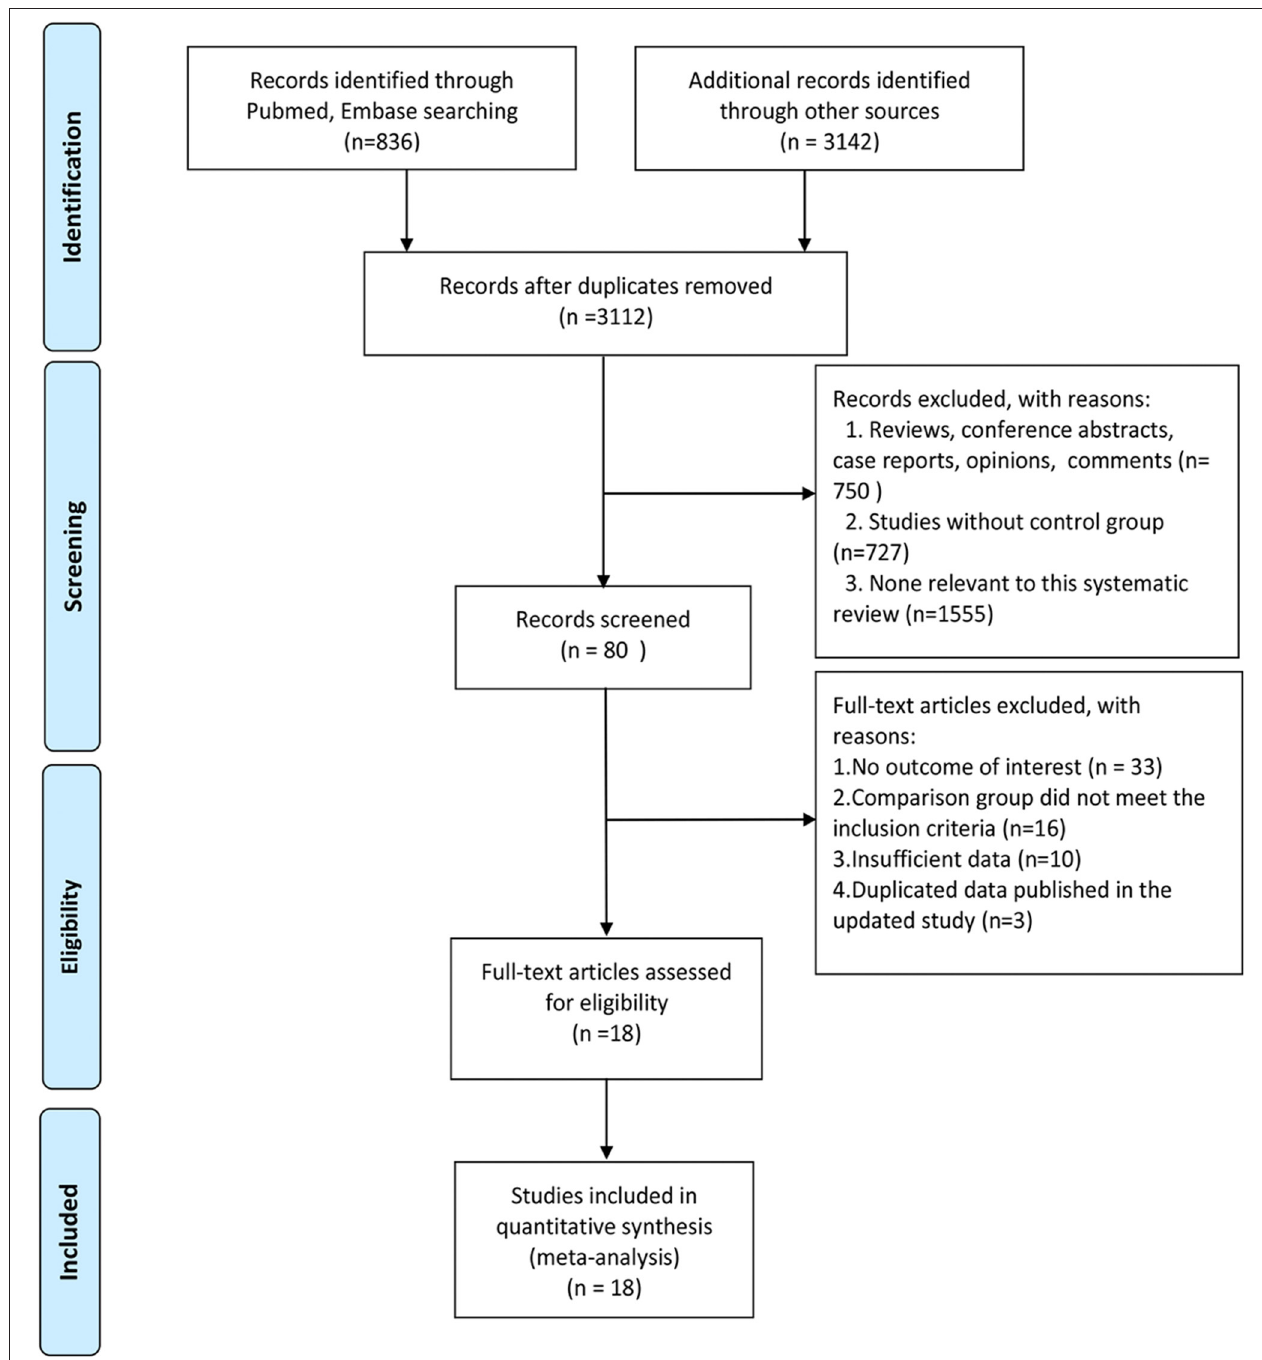
FIGURE 1 | A PRISMA FlowChart of study selection.